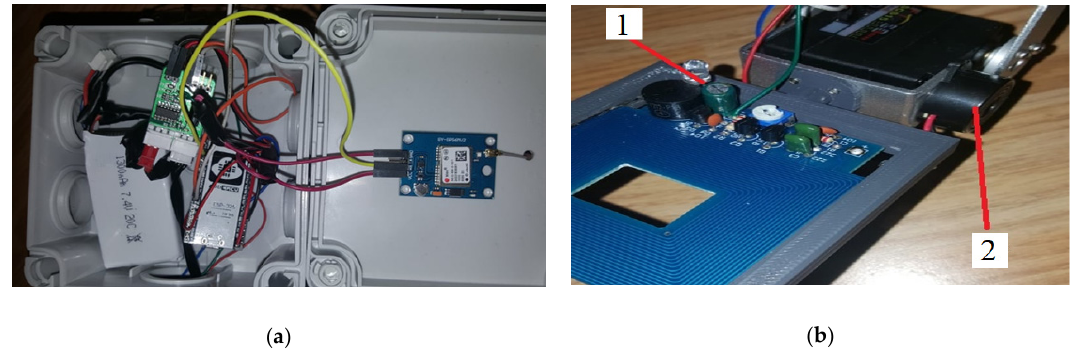
Figure 6. Electronic connection between the GPS module and the microcontroller, as well as additions to the metal sensor: ( a ) wiring of the GPS structure with the microcontroller board; ( b ) detector.